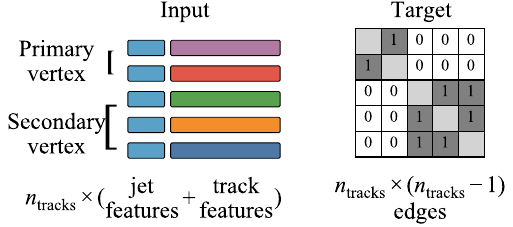
Fig. 3 The input and training target for the neural network algorithms. For a jet with n tracks , the input is an array of n tracks × d in track and jet features (jet features are represented by the light blue boxes, track features by the colored boxes), and the target output is a binary classifi- cation label for each of the n tracks × ( n tracks − 1 ) ordered pairs of tracks in the jet